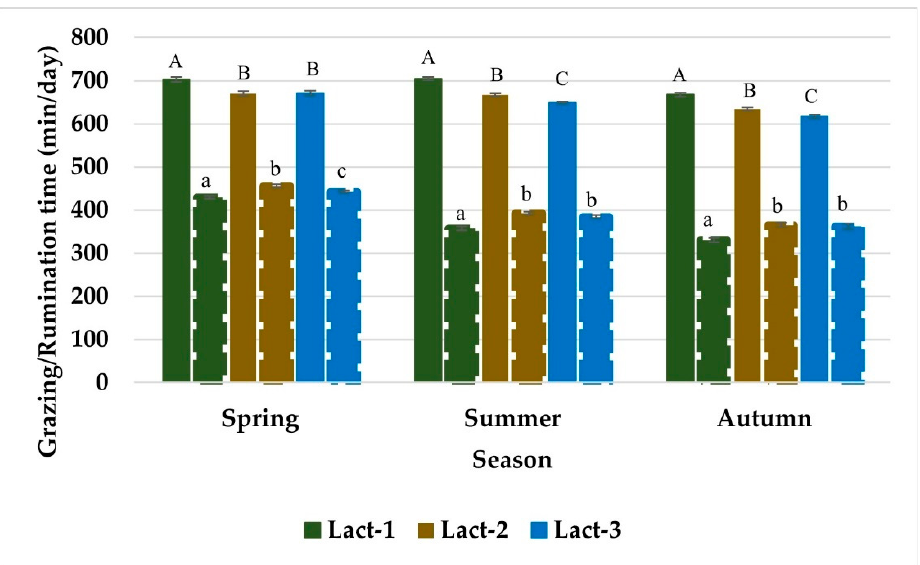
Figure 4. Grazing time (min/day) and rumination time (min/day) of dairy cows in lactation year 1 (lact-1), lactation year 2 (lact-2) and lactation year 3 (lact-3) across three seasons over the lactation period for Year-1. Compact bars show grazing time and dotted bars show rumination time. Error bars represent standard error. Letters on each bar show significant differences between bars, capital letters for grazing time and small letters for rumination time.